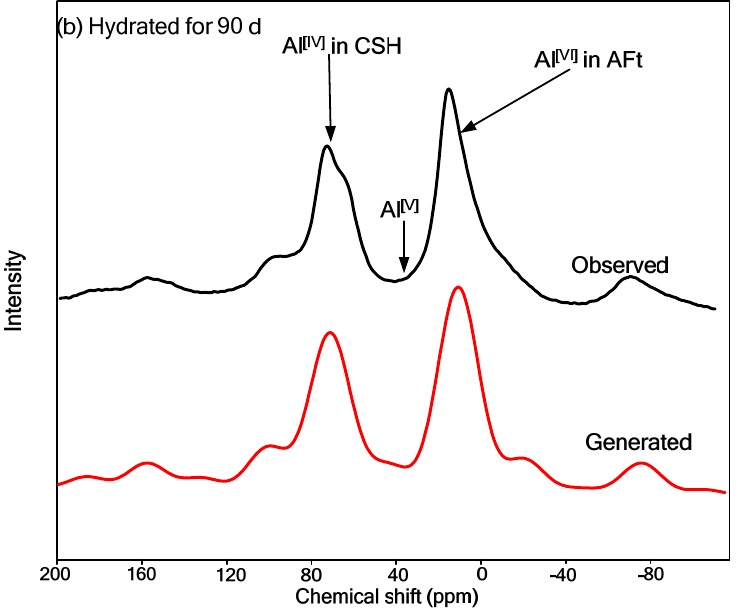
Figure 11. 27 Al MAS − NMR spectra of solidified/stabilized gold tailings: ( a ) cured for 3 d; ( b ) cured for 90 d.